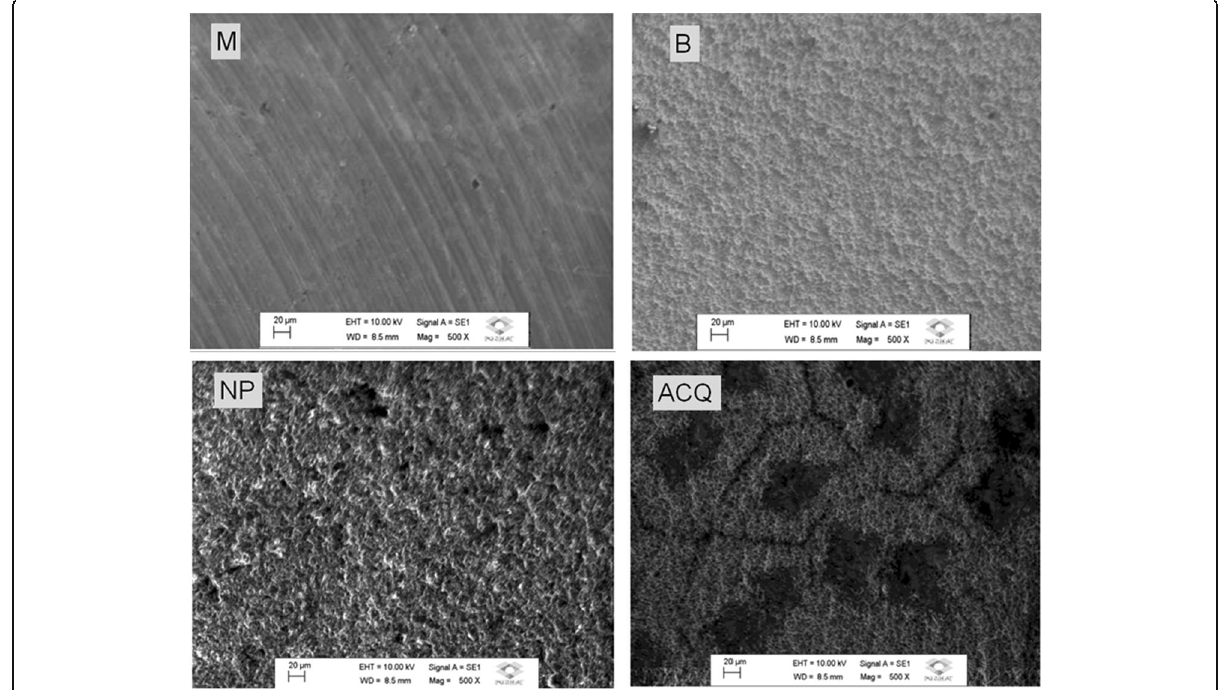
Fig. 1 SEM photomicrographs. Titanium disks with machined (M), sandblasted (B), Neoporos® (NP), and Acqua® (ACQ) surfaces